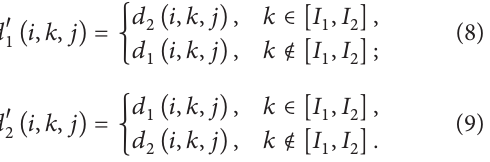
𝑥 (𝑗) is obtained. Substitution of 𝑥 𝑖 objective function 𝑓(𝑗) . The smaller the value 𝑓(𝑗) is,